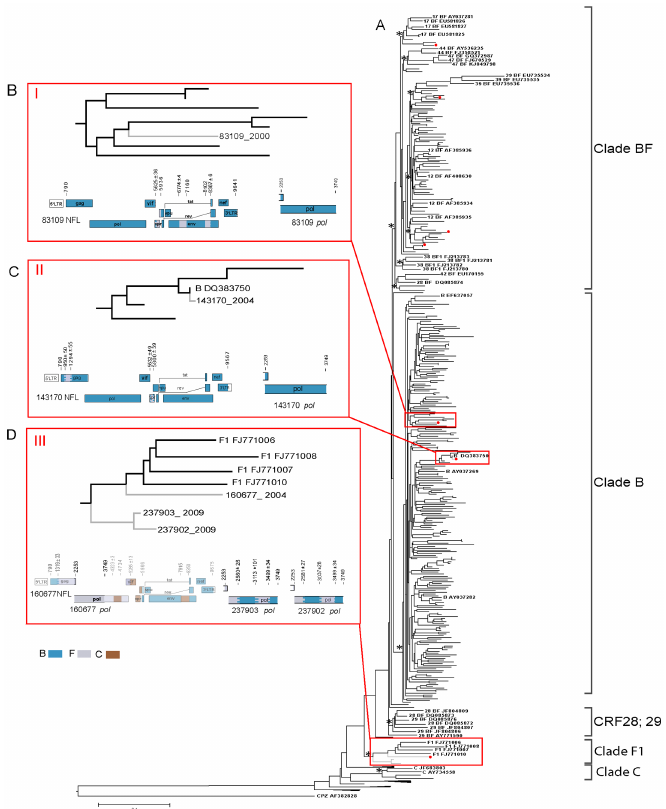
Fig 1. Phylogenetic tree of pol sequences and genetic mosaic for the recombinant sequences misclassified by phylogeny. (A) Maximum likelihoodphylogenetic tree of the HIV-1 pol (1467 nt) sequences obtained from 312 Argentinean MSM. ReferencesequencesincludeBF recombinant and pure subtype sequencesand the tree was rooted using SIVcpzGAB2 as outgroup.The branch support values are indicated with an asterisk (aLRT > 0.9) at key nodes. The seven pol sequencesindicatedwith a red dot at terminal node were subsequently characterized as BF recombinant by means of NFL analysis. Red boxes are clusters of nucleotide sequencesexhibiting discrepancies between pol gene- and NFL-basedsubtype assignment are zoomed in (Fig.1B), (Fig.1C), and (Fig.1D). Genetic mosaic maps for #83109(box I) and #143170(box II) pol sequencesare consistent with phylogenyshownin Fig.1A but the NFL-sequence genetic mosaics exhibitas BF recombinants (Fig.1B and 1C, respectively). The #237902, #237903 pol sequences(box III) are phylogeneticallyascribed to pure subtype F (Fig.1A) but their genetic mosaic exhibitedthem as BF recombinants. The #160677 pol sequence(box III) also phylogenetically classified as pure subtype F, shows a NFL-basedgeneticmosaic characterized as B-C-F recombinant